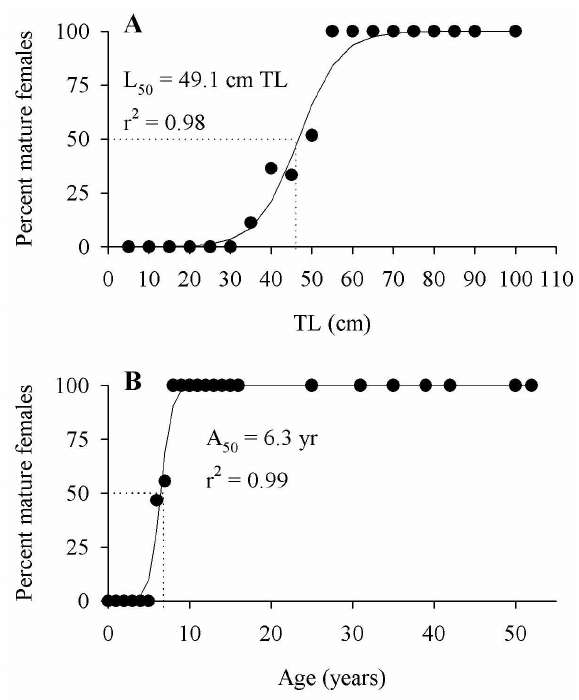
Fig . 6. – Percentage of mature females per length (A) and age (B) classes of Epinephelus marginatus. Dashed lines indicate estimates of size and age at 50%